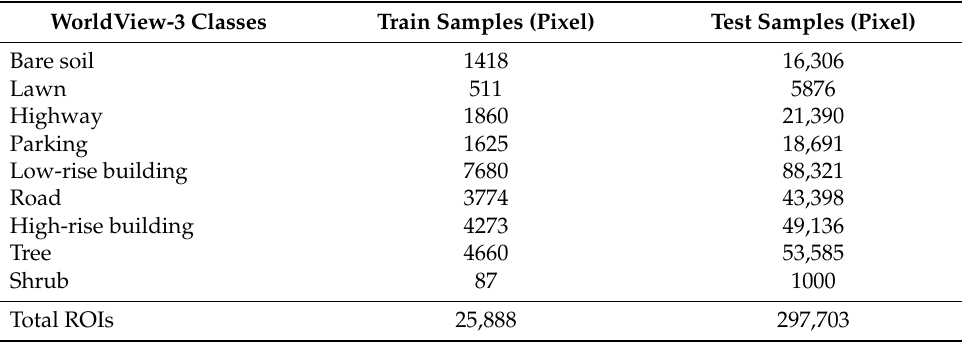
Table A6. Training and test samples for each class in the Rio